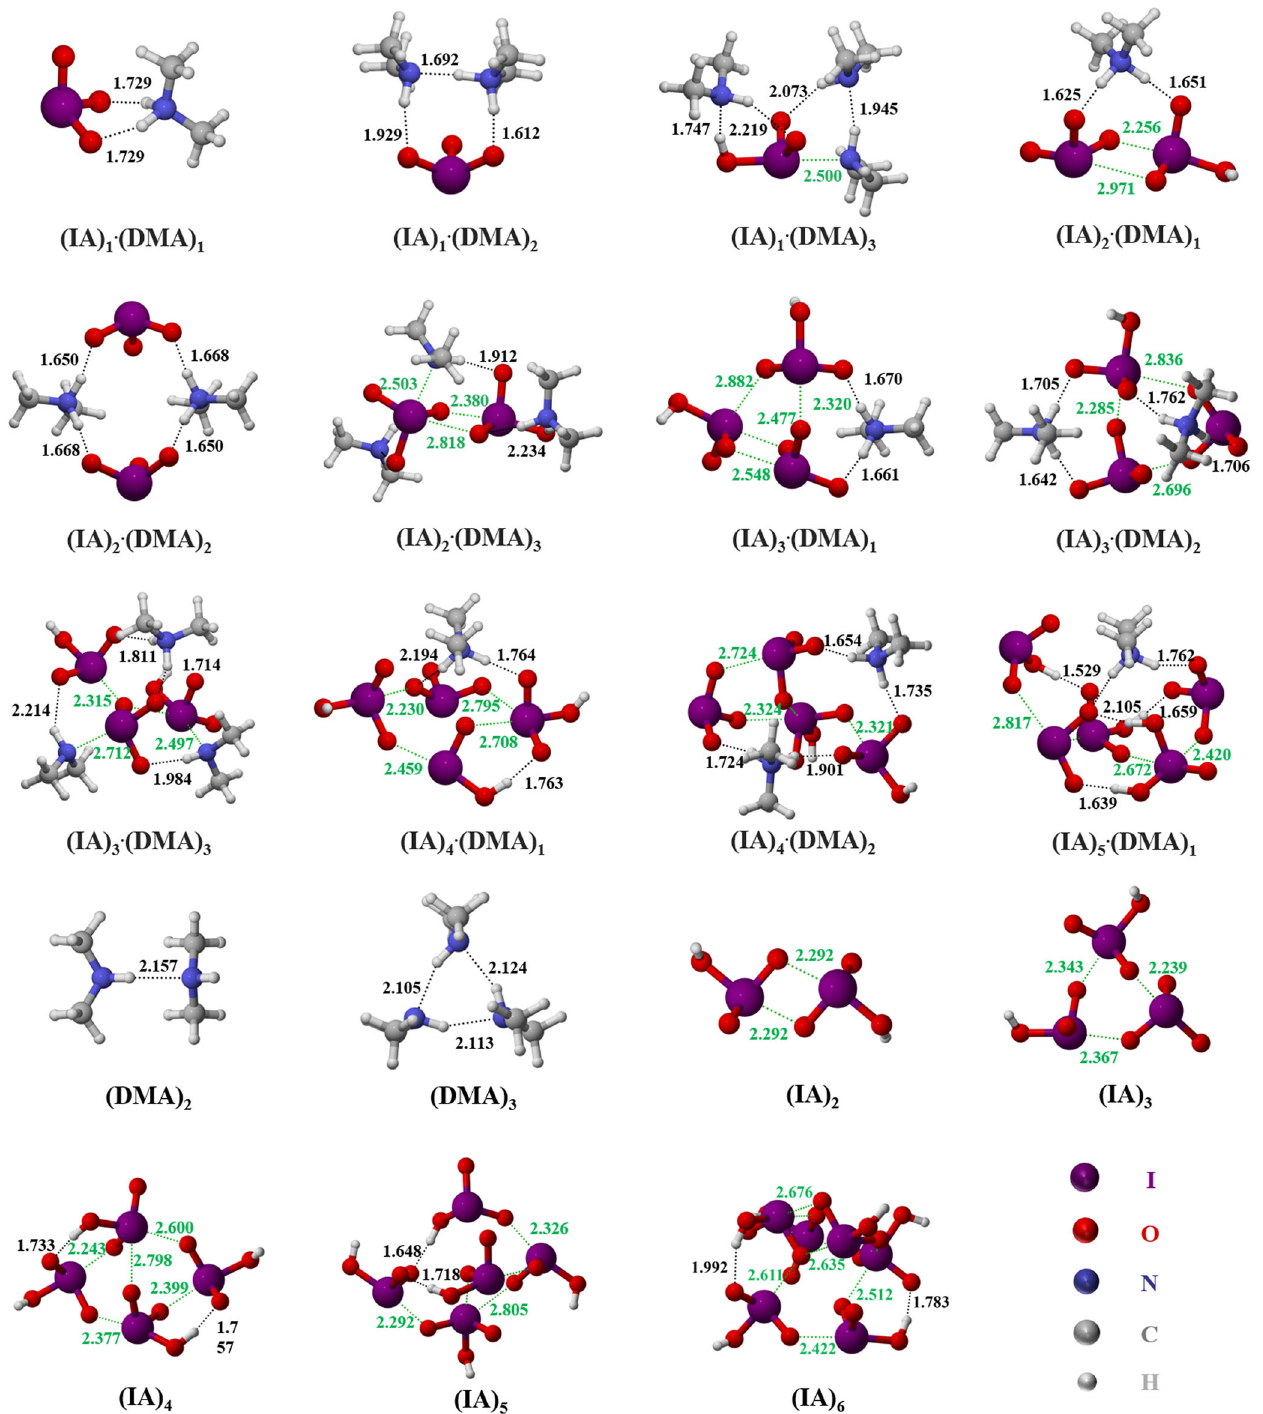
Fig. 2 The most stable cluster con fi gurations. The (IA) x . (DMA) y (1 ≤ x ≤ 6, 1 ≤ y ≤ 3, 2 ≤ x + y ≤ 6) clusters with lowest Gibbs formation free energies at the ω B97XD/6-311 ++ G(3df, 3pd) (for C, H, O, N atoms) + aug-cc-pVTZ-PP with ECP28MDF (for I atom) level of theory. The black and green dashed lines indicate the formed HBs and XBs, respectively. The lengths of bonds are given in Figure 4 presents J of the pure - IA (blue line), IA-NH 3 (yellow promote the rate J , indicating that both have an enhancement area), and IA-DMA systems (red area) at the corresponding effect on the formation of IA clusters. Interestingly, the far lower precursor concentrations over the oceans: [IA] = 10 6 ~10 8 (mole- [DMA] (0.01~10 pptv) relative to [NH 3 ] (40~10 3 pptv) can promote cules cm − 3 ) 12 , [DMA] = 0.01~10 pptv 23,33 and [NH 3 ] = 40~10 3 J to a higher level (red area), indicating that the formation of IA- involved particles is more sensitive to the enhancement effects of pptv 31,34 . As shown in Fig. 4, compared with pure-IA nucleation, DMA. It is worth noting that the enhancement of DMA on J the involvement of both DMA and NH 3 in clustering signi fi cantly